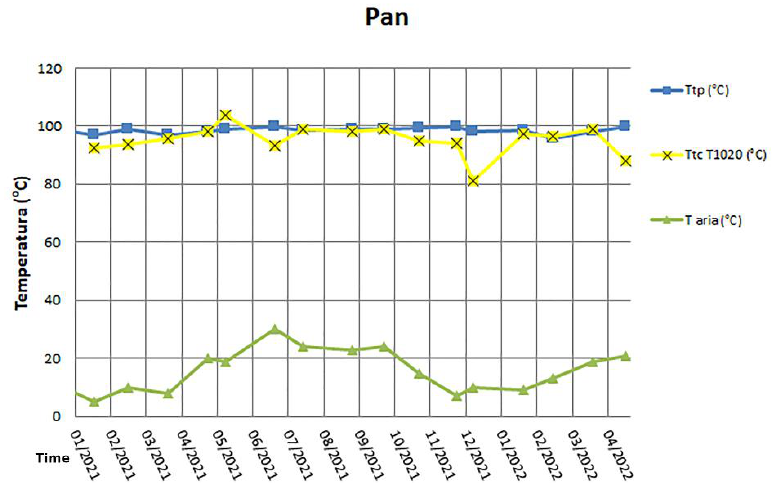
Figure 3. Example of manual processing of thermal parameters at the Pantane (Pan) station of the Island of Ischia (Figure 1). Here the time trend of maximum temperature from thermal image (Ttp), temperature from K thermocouple (Ttc) and air temperature from the thermo-hygrometer (T aria) are shown.